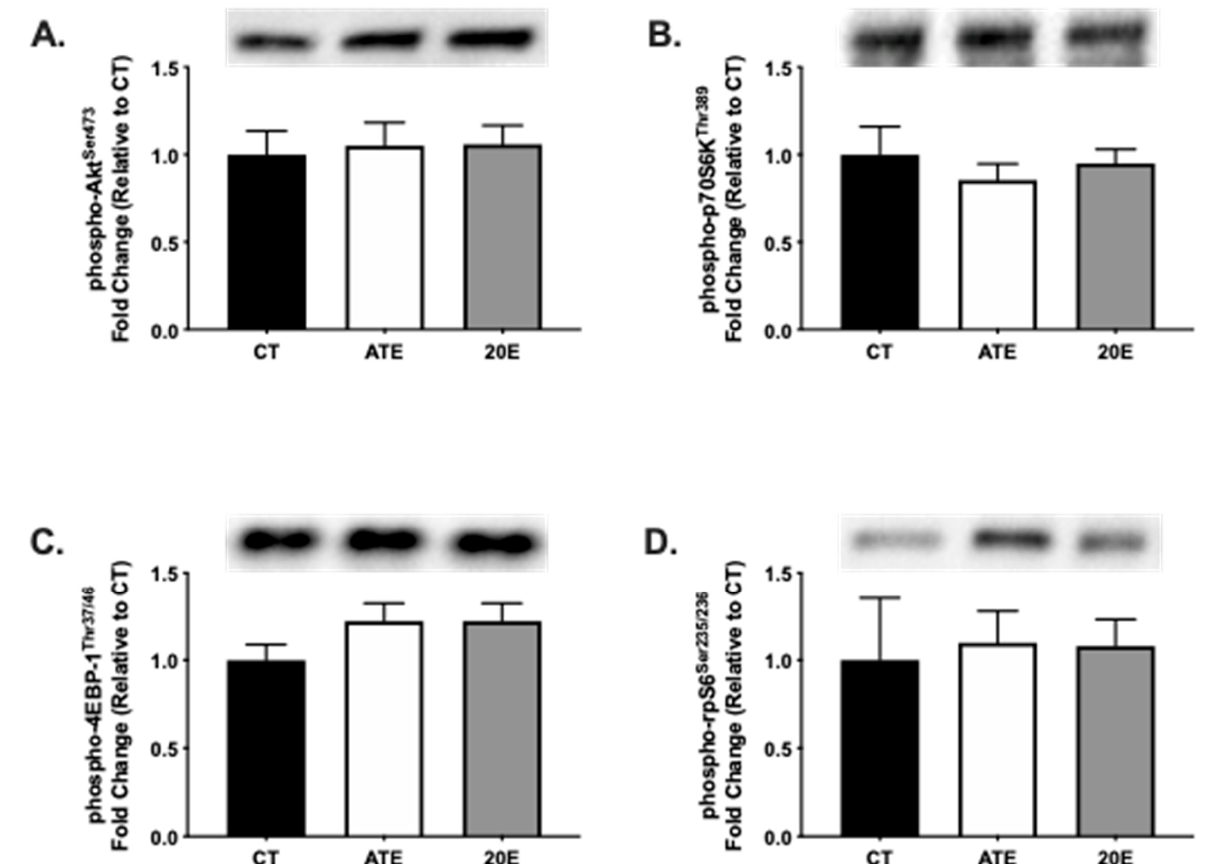
Figure 3. Protein analysis of markers of protein synthesis signaling in aging gastrocnemius muscle via Western blot after an acute dose of supplementation. Quantification of phosphorylated Akt ( A ), phosphorylated p70S6K ( B ), phosphorylated 4EBP-1 ( C ), and phosphorylated rpS6 ( D ) protein by treatment, respectively. Representative Western blot protein bands are provided. Data are normalized to CT and presented as mean ± SEM. CT, control; ATE, A. turkestanica extract; 20E, 20-hydroxyecdysone. No significant differences were found, p > 0.05, all.